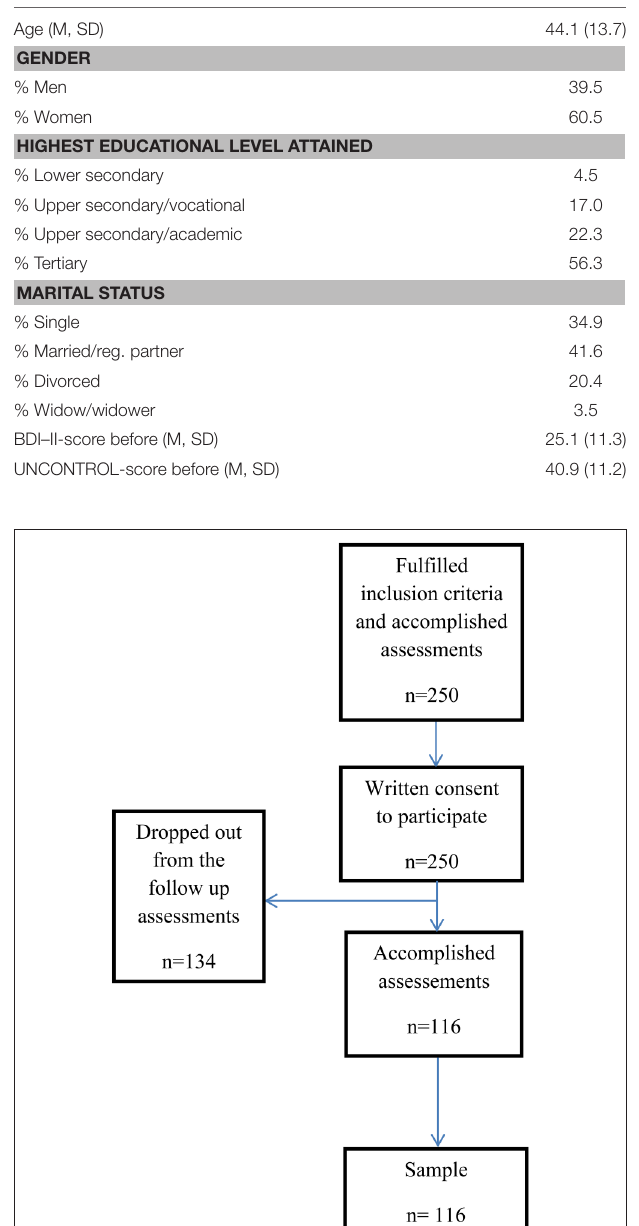
TABLE 1 | Patient demographics, BDI–II-score, and UNCONTROL-score before treatment ( N = 116).